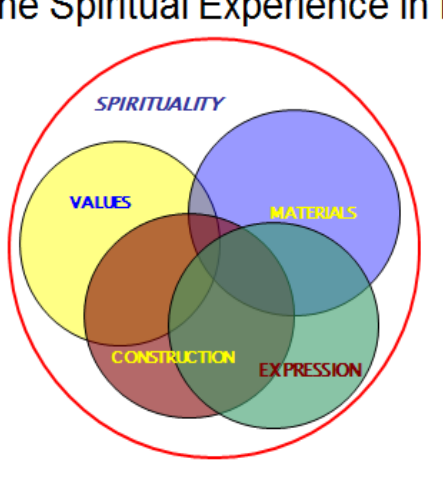
Figure 1: Model for spiritual experience in music Boyce Tillman